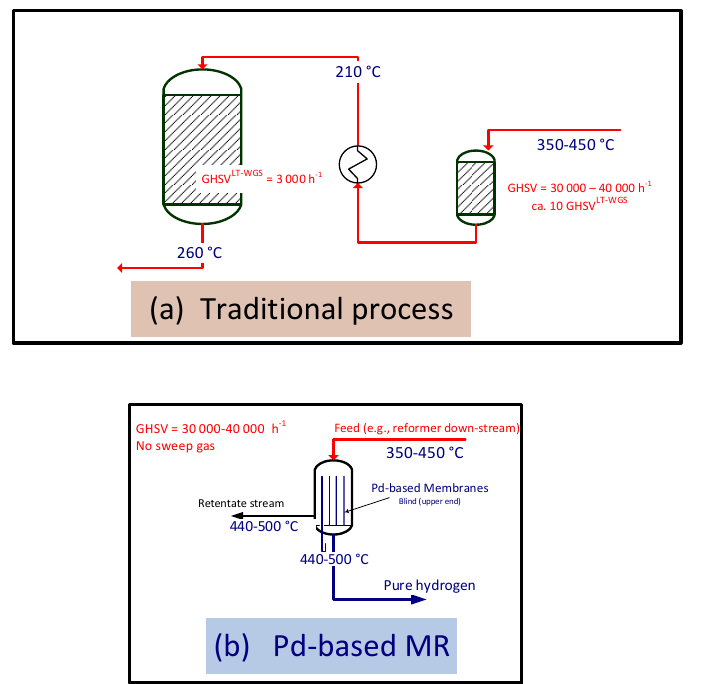
Figure 2. Comparison between the conventional reactor system and a Pd-based membrane reactor for the WGS (water gas shift) reaction system. Reprinted from [14] with the permission of the Royal Society of Chemistry (RSC).